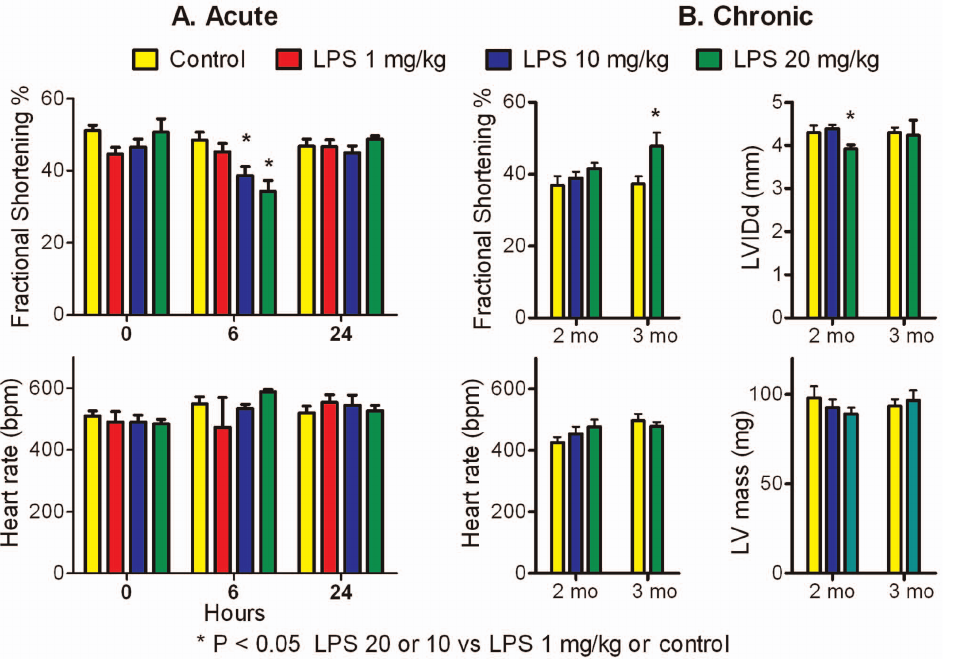
Figure 2. Acute and chronic effects of LPS on left ventricular (LV) size and function by echocardiography. Panel A: LV fractional shortening and heart rate (beats per minute, bpm) measured before (0 hours), and 6 and 24 hours after i.p. injection of saline (control), LPS 1, 10, or 20 mg/kg (each bar, mean + SEM, n=6). There was a mild decrease in LV fractional shortening after 6 hours with LPS 10 and 20 mg/kg (*P , 0.05 vs LPS 1 mg/kg or control) that resolved by 24 hours. Panel B: LV fractional shortening, heart rate, LV internal diameter in diastole (LVIDd), and LV mass measured after 2 months of weekly i.p. injections of saline (n=11), LPS 10 mg/kg (n=8) and LPS 20 mg/kg (n=12), and after 3 months of weekly i.p. injections of saline (n=13) or LPS 20 mg/kg (n=5). There were a few minor changes with LPS 20 mg/kg (*P , 0.05 compared with control), but no significant decrease in LV function, LV dilation, or change in LV mass.